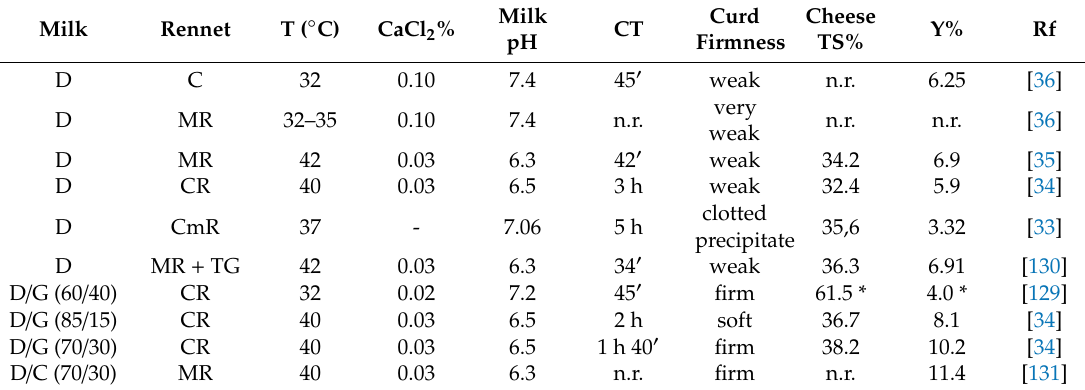
Table 3. Technological conditions for manufacturing cheese from donkey